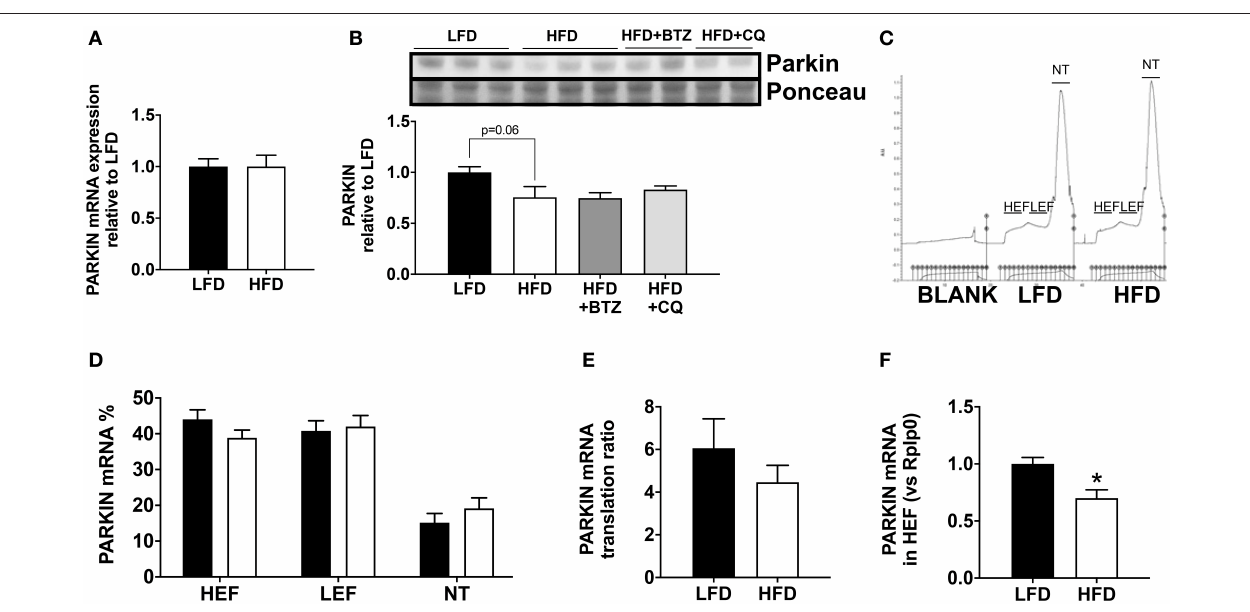
FIGURE 3 | Regulation of Parkin protein abundance. The cardiac mRNA expression of Parkin (A) . The protein expression of Parkin was analyzed Western blot analysis (B) in LFD and HFD mice and HFD mice treated with Bortezomib (1 mg/kg) or Chloroquine (50 mg/kg). UV densitometry tracing of RNA in the sucrose gradient for polysome profiling (C) . Polysome profiling to detect distribution of Parkin mRNA in high-efficiency (HEF) and low-efficiency (LEF) polysomes and the non-translating (NT) fraction (D) . Quantitation of Parkin mRNA translation ratio [(HEF + LEF)/NT] (E) . Quantitation of Parkin mRNA level in the HEF (F) . Results ( n = 5–6/group) are expressed in mean ±